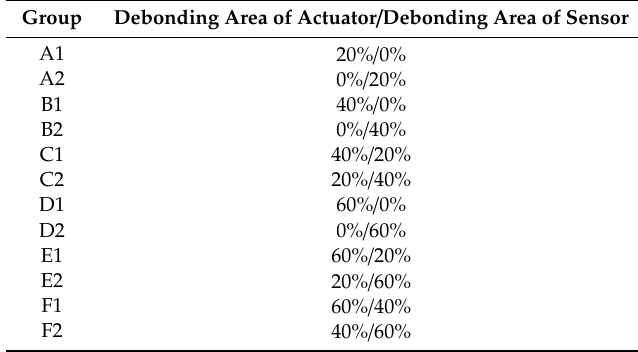
Figure 15. The normalized amplitude of the signal changes when the actuator and the sensor are decoupled. Table 5. Combination of actuator and sensor with di ff erent debonding area.